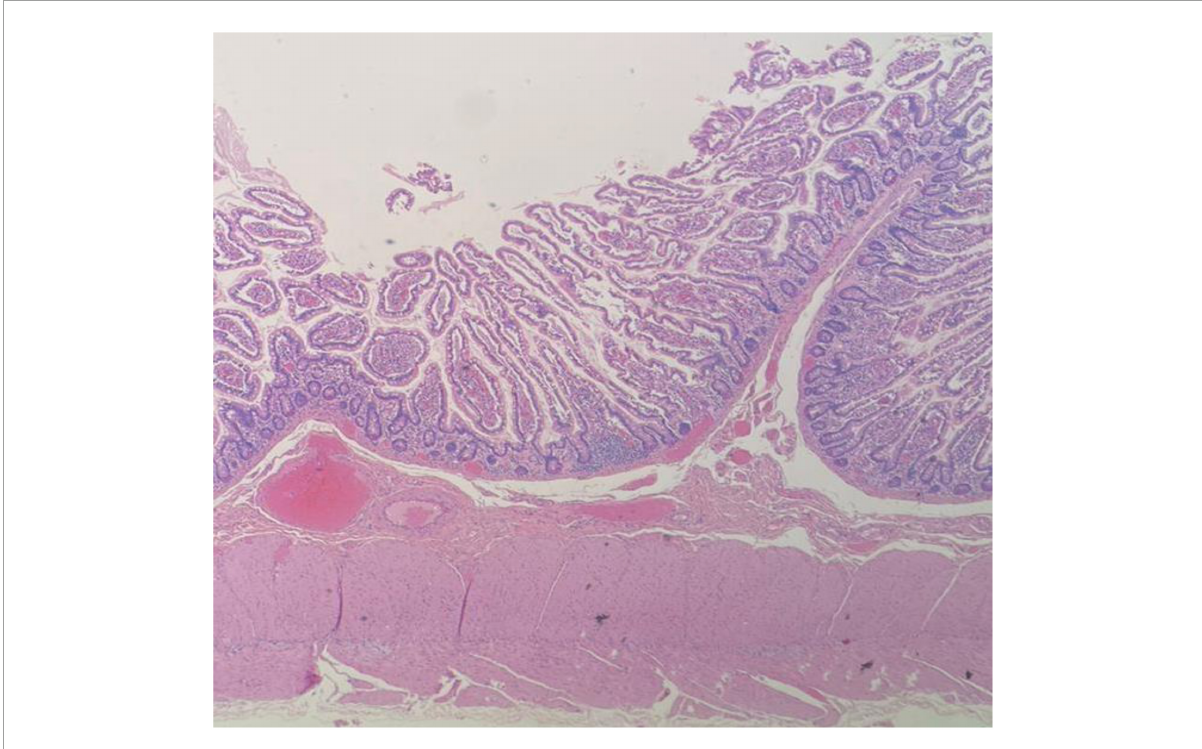
FIGURE3 Microscopic image of intact jejunal bowel adjacent to tumor site, LPF.